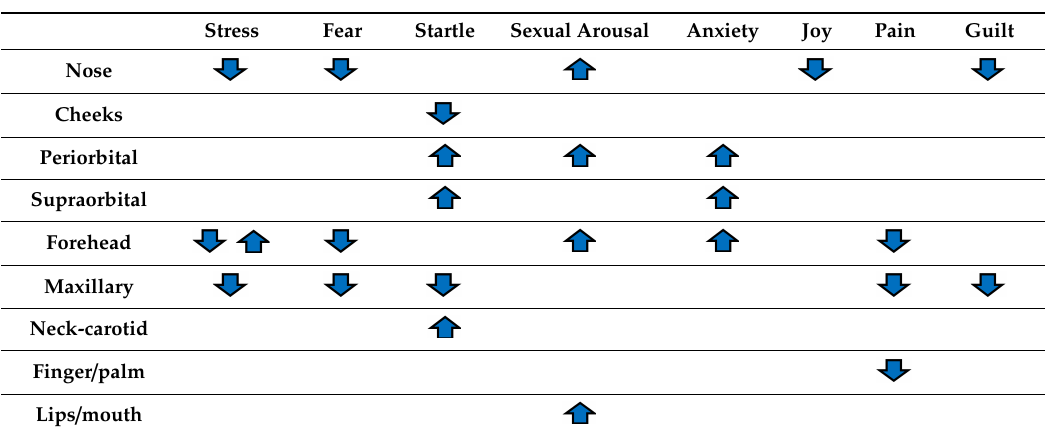
Table 1. Overview of the temperature variations direction, as estimated through thermal IR imaging, for each emotion in the di ff erent regions considered. The table is adapted from